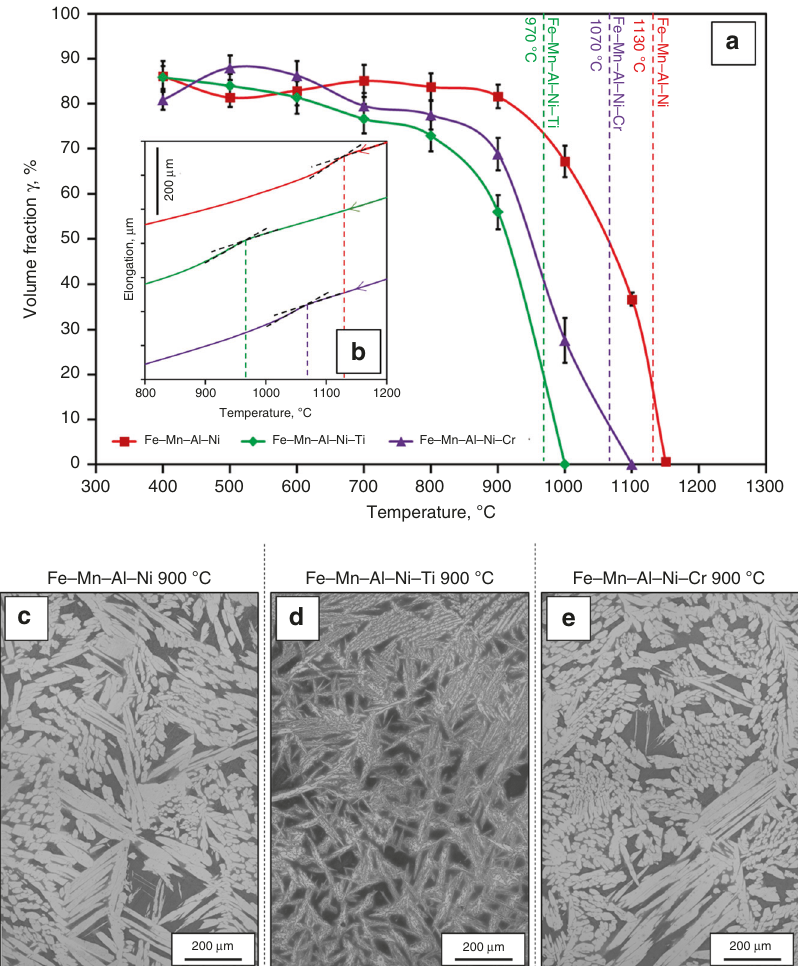
Fig. 3 Volume fraction and microstructural appearance of γ phase in the two-phase region. a Volume fraction of γ phase after the heat treatment procedures shown in Supplementary Fig. 1b and corresponding γ solvus temperatures measured by dilatometer tests during cooling ( b ). Characteristic microstructures of Fe – Mn – Al – Ni ( c ), Fe – Mn – Al – Ni – Ti ( d ), and Fe – Mn – Al – Ni – Cr ( e ) after the same heat treatment procedure (cf. Supplementary Fig. 1b) with a lower temperature of 900 °C. Error bars in a indicate the con fi dence intervals for the investigated conditions